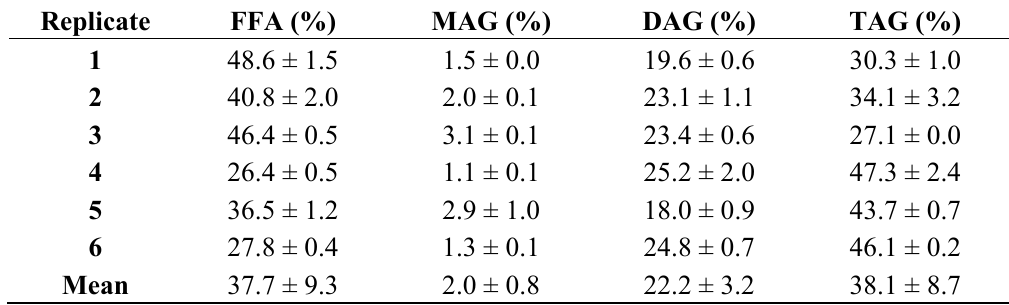
Table 4. Compositions of lipid materials extracted a